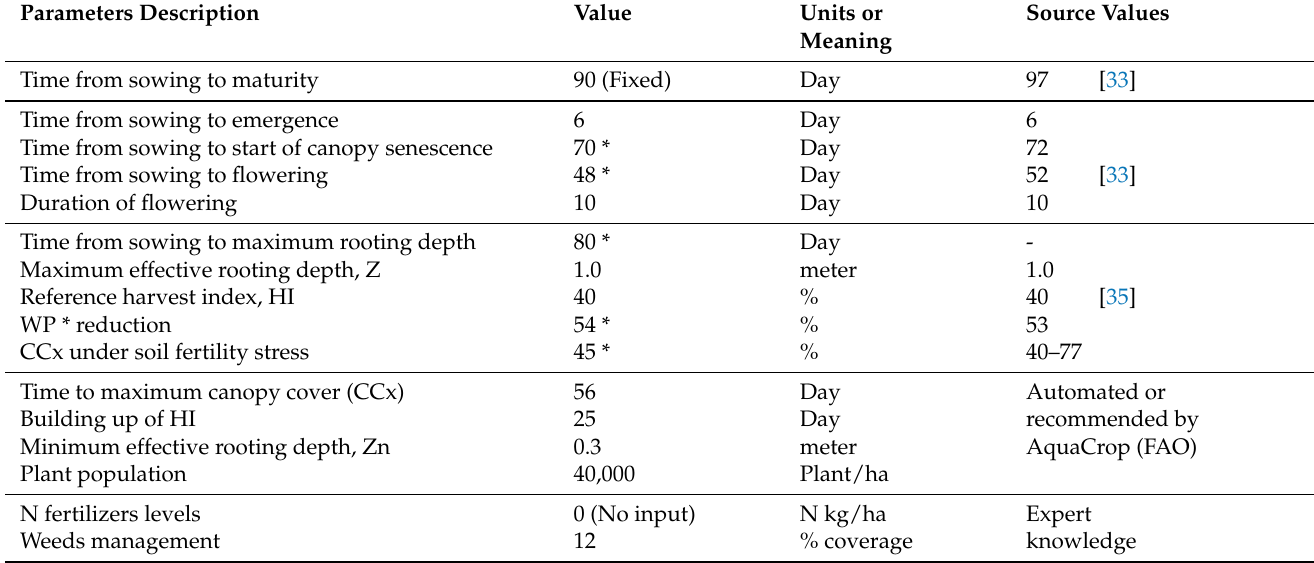
Table 3. Non-conservative parameters adjusted (*) based on [33] for 90 days maturation Maize and